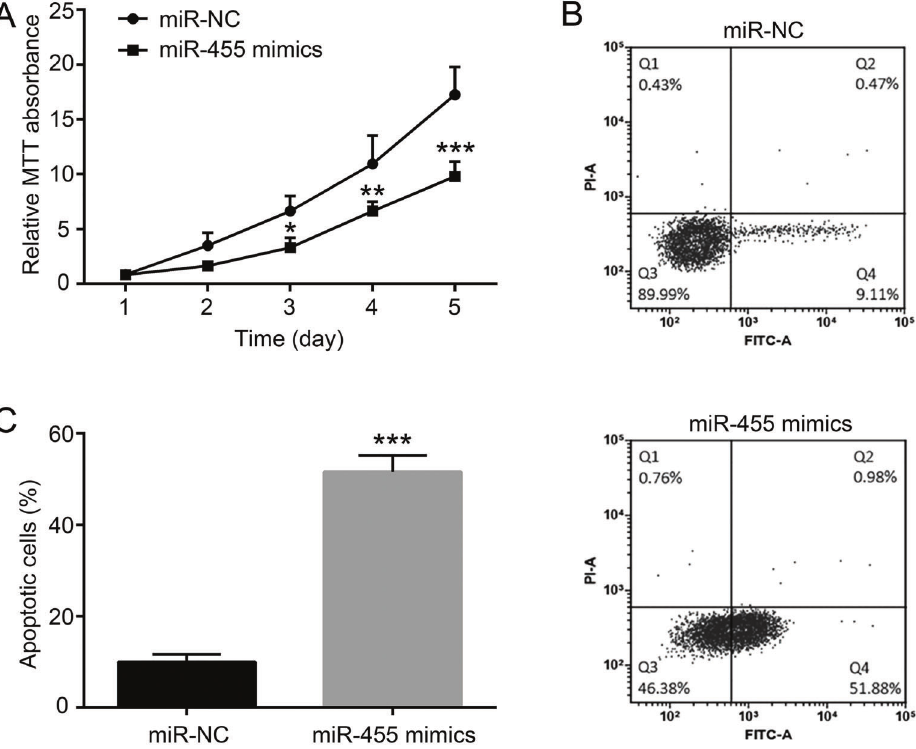
Figure 5. miR-455 inhibited proliferation and induced apoptosis of HCT116 cells. Cell viability ( A ) and cell apoptosis ( B and C ) of cells transfected with miR-NC or miR-455 mimics were measured by MTT assay and fl ow cytometry, respectively. Data are reported as the mean ± SD of 3 independent experiments. *P o 0.05; **P o 0.01; ***P o 0.001 (two-tailed unpaired t -test). MTT: 3-(4,5-dimethylthiazol-2- yl)-2,5-diphenyltetrazolium bromide; HDAC2: histone deacetylase 2; miR-455 mimics: microRNA-455 mimics; miR-NC: negative control of